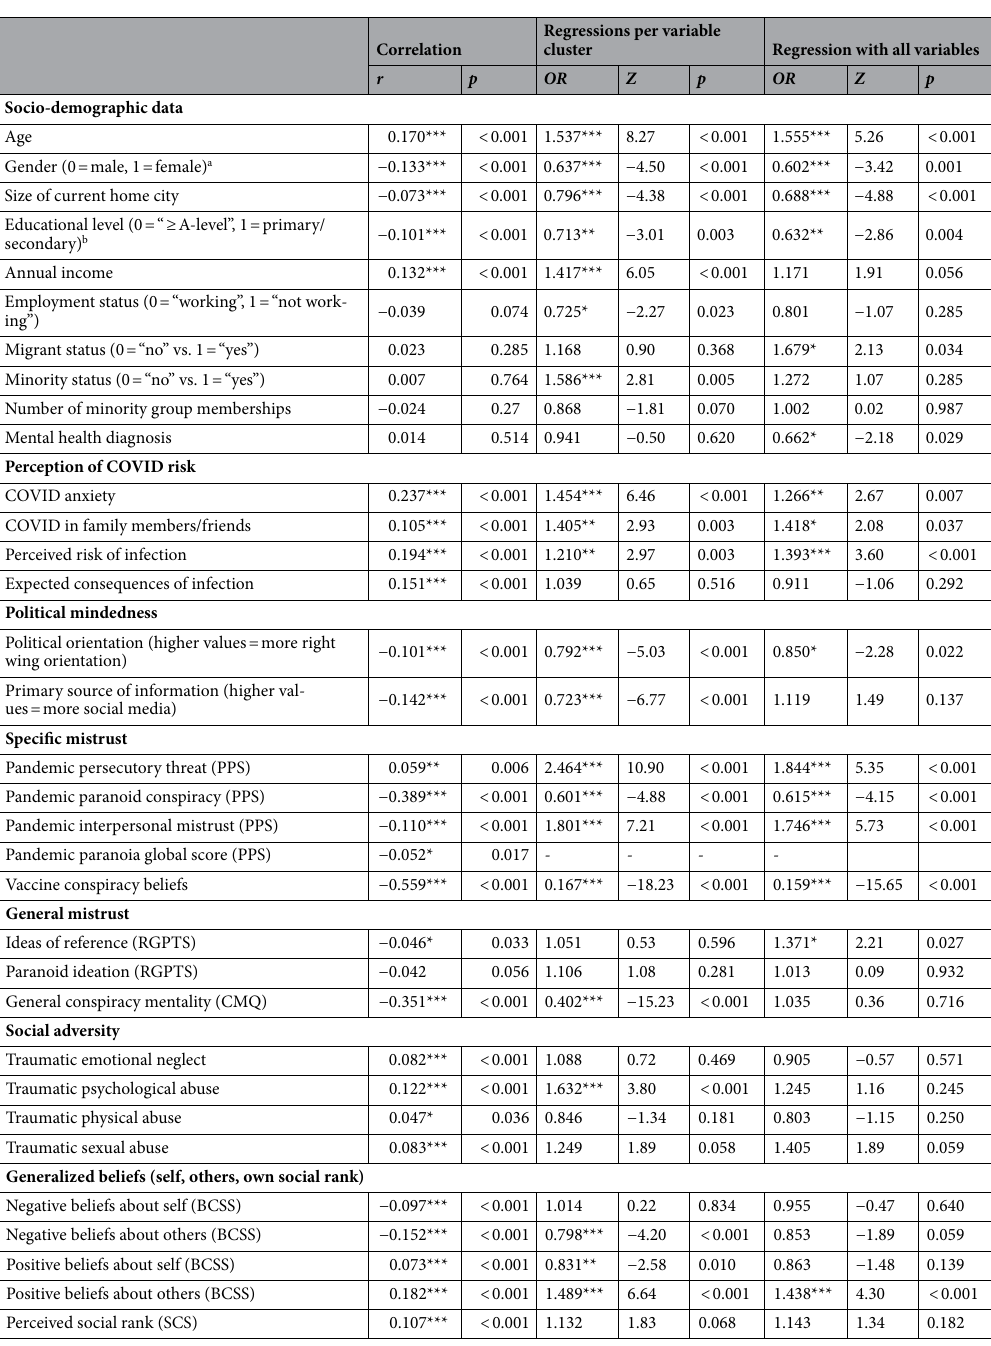
Table 3. Correlation and multifactorial logistic regression analyses predicting vaccine willingness vs. hesitancy (n = 2116). (a) To avoid bias due to low cell counts the variables sex and gender were combined into a dichotomized variable to reflect the gender a participants most likely reads as at present (e.g. a person describing their sex as male and their gender as trans/female was labeled as female; a person describing their sex as female and their gender as other was labeled as female) leading to a recoding for 16 participants (0.63%); (b) education level was dichotomized with GCSE or lower categorized as low educational level and everything else as high educational level. PPS pandemic paranoia scale, CMQ conspiracy mentality questionnaire, RGTPS revised green paranoid thoughts scale, BCSS brief core schema scales, SCS social comparison